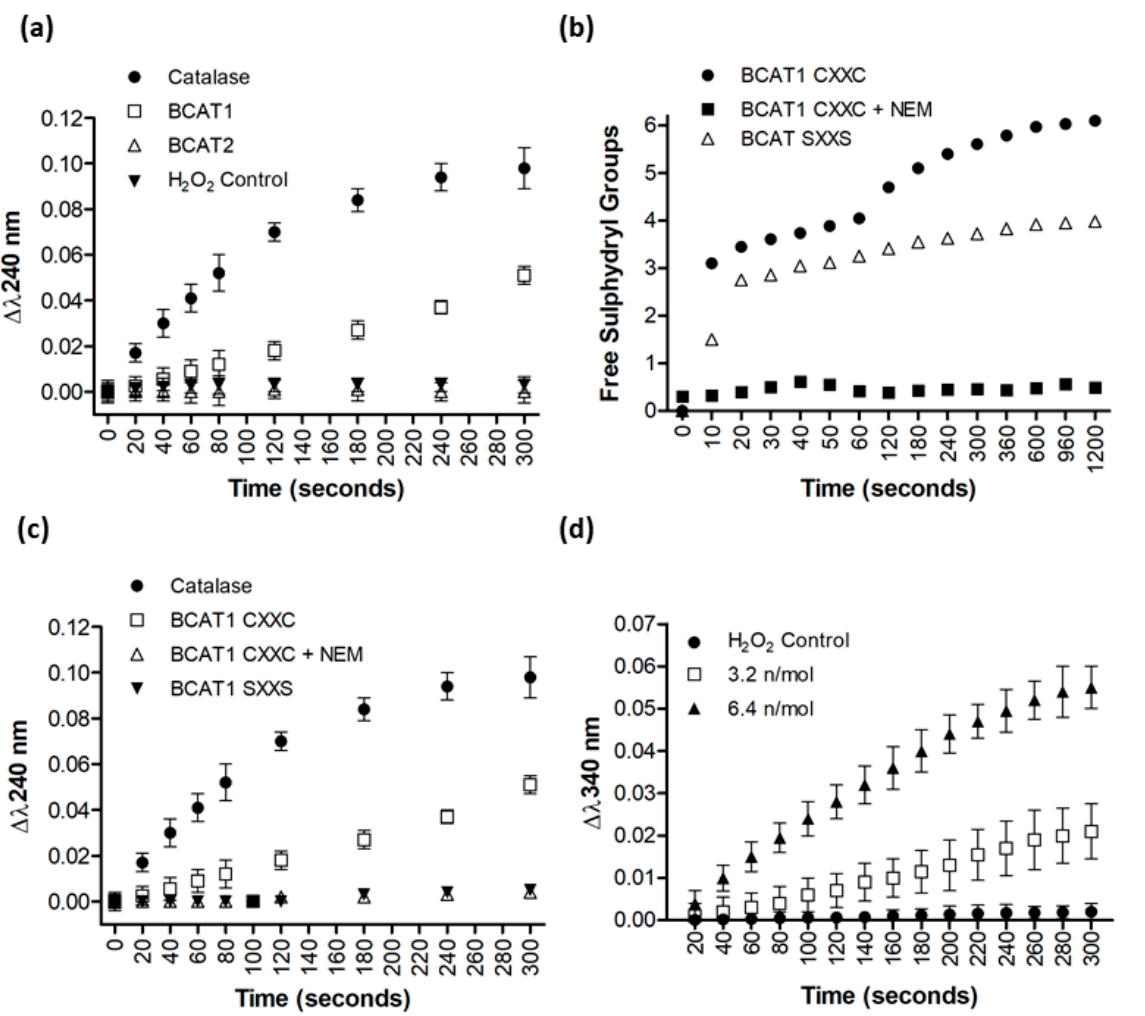
Figure 2. Purified recombinant WT BCAT1 protein metabolises H 2 O 2 in vitro. ( a ) Evaluation of the capacity of WT BCAT1 and WT BCAT2 to metabolise H 2 O 2 compared with catalase. ( b ) Site-directed mutagenesis of the BCAT1 CXXC motif was confirmed by DTNB titration for the number of free cysteine thiol for WT BCAT1, WT BCAT1 treated with NEM and CXXC motif mutant BCAT1 (SXXS). ( c ) Evaluation of the capacity of WT BCAT1,